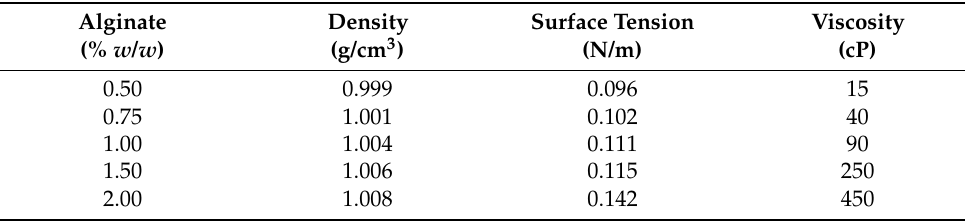
Table 1. Properties of the alginate solutions.